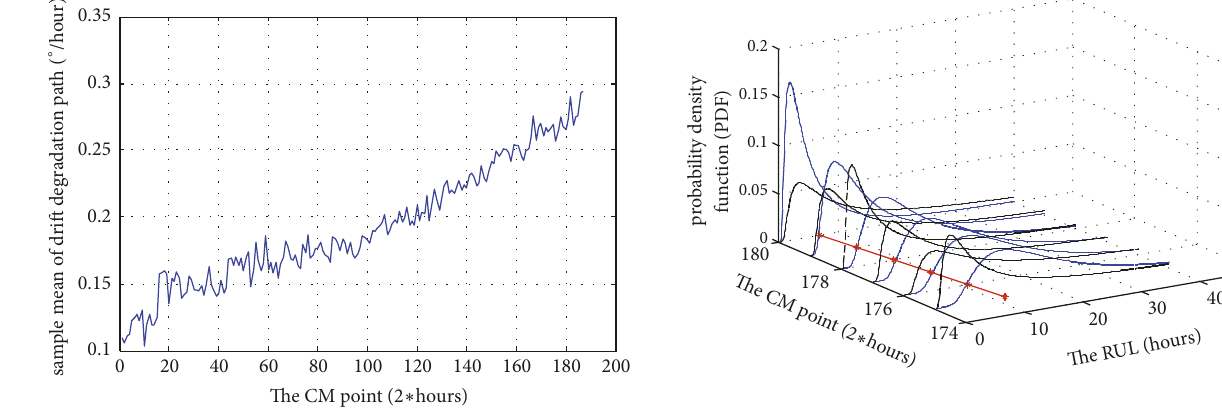
Figure 1: The sample mean of the gyro drift.